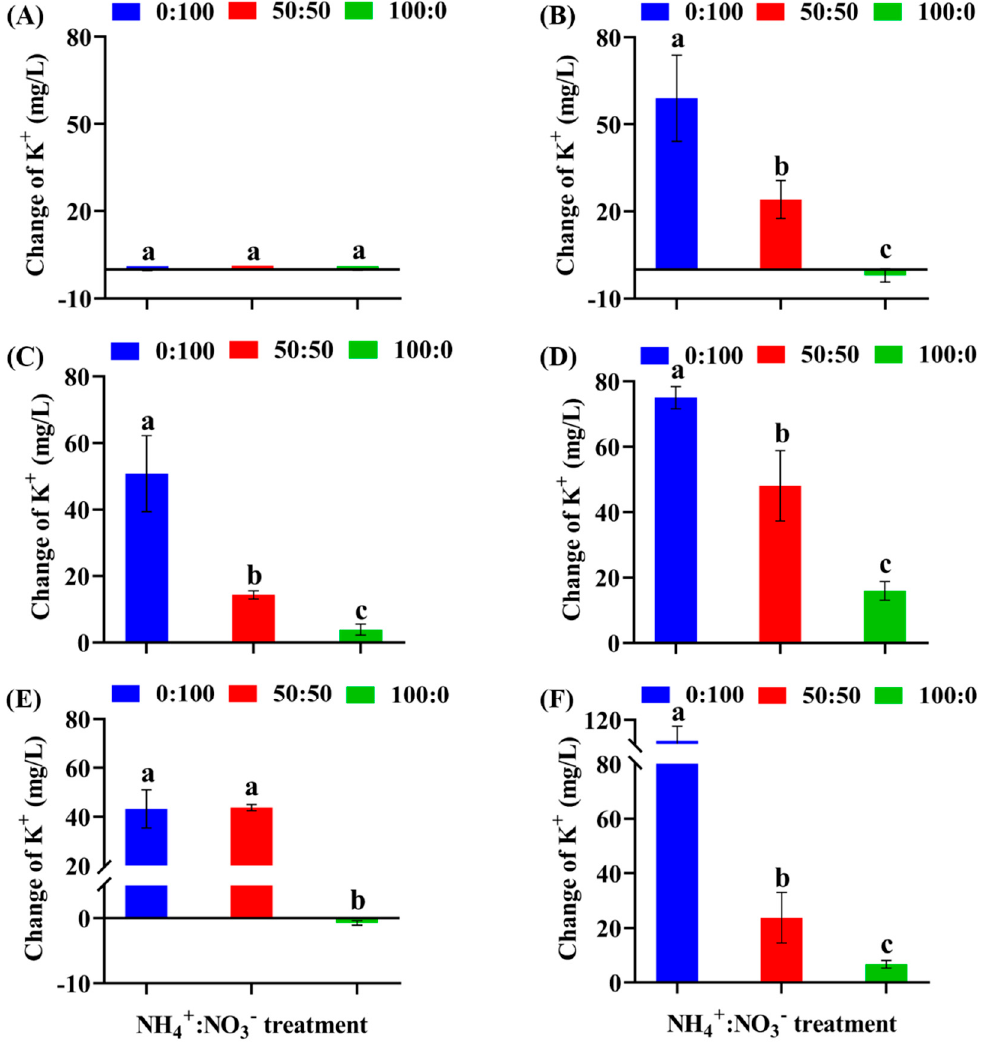
Figure 4. The K + content changes in three NH 4+ :NO 3 − hydroponic solutions supplied for ( A ) the control (without plants); ( B ) salvia; ( C ) petunia; ( D ) ageratum; ( E ) cabbage; and ( F ) lettuce. Data are means ± SD representing n = 3 biological replicates. Columns accompanied by different lower-case letters were regarded as significantly different, according to the one-way ANOVA following the Duncan’s multiple range test at p = 0.05.